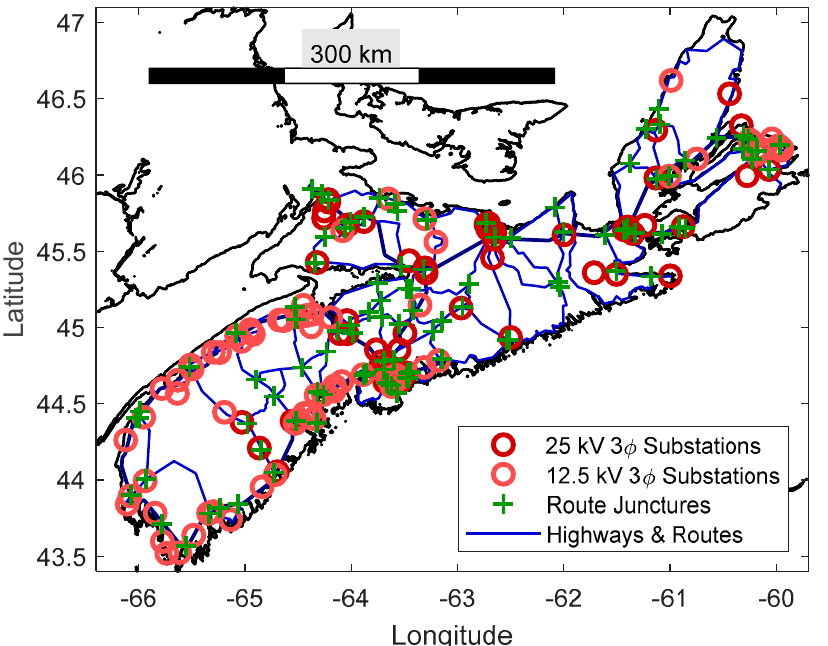
Figure 2. Map of major route junctures (green ‘+’) and 3-phase distribution substations (red and pink circles).